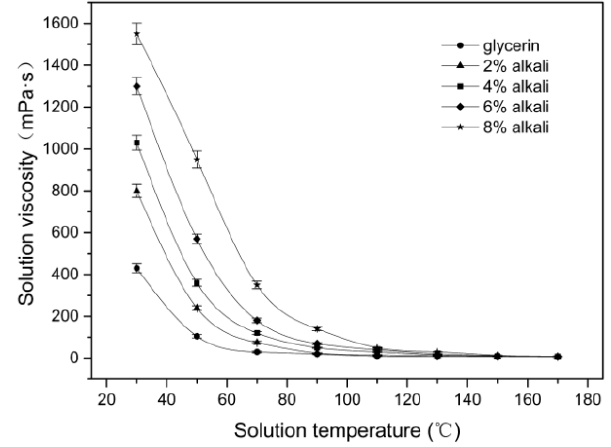
Figure 1. Relationship between the viscosity and temperature of the alkali/glycerin mixtures.